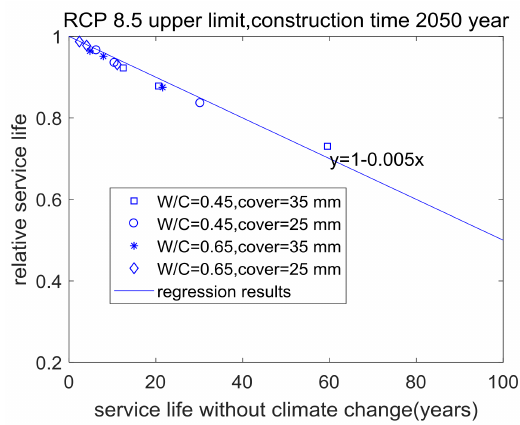
Figure 19. Relative service life of cracked concrete-RCP 8.5 upper 90% confidence interval, time slice